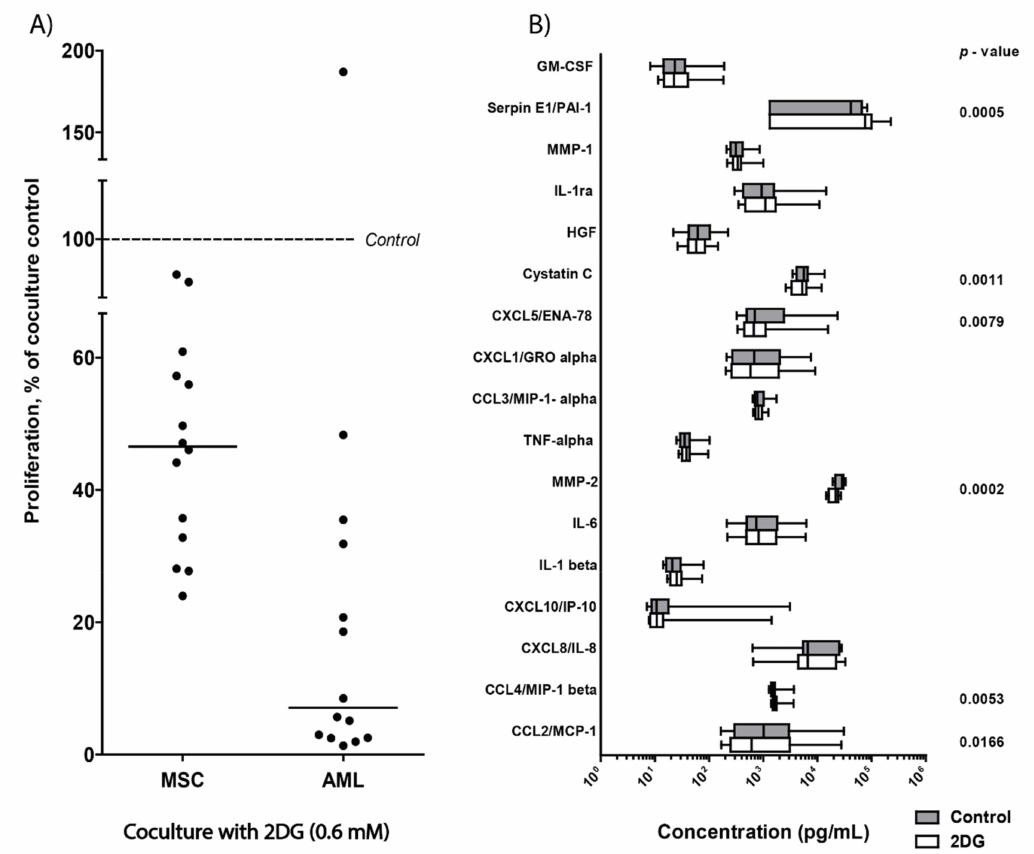
Figure 7. Cell proliferation and mediator release after in vitro coculture of primary human AML cells and normal mesenchymal stem cells (MSCs), after treatment with the glycolytic inhibitor 2DG. Primary AML cells derived from 14 patients were cultured together with normal MSCs in transwell cocultures for 3 days in the presence of 2DG, before proliferation was assayed using the [ 3 H]-thymidine incorporation assay. Mediator levels were also determined in coculture supernatants with and without 48-hour treatment with 2DG, using multiplex analysis. ( A ) E ff ect of 2DG on cell proliferation in MSC-AML cocultures. Proliferation of MSCs or AML cells in 2DG-treated cocultures relative to the inhibitor-free control cocultures (shown as stippled line at 100%) was calculated and an antiproliferative e ff ect by 2DG was then observed both for the MSCs (derived from one donor) and the AML cells (derived from 14 patients) during coculture. The median proliferation of the MSC cells and the AML primary cells after treatment in cocultures is indicated in the figure( - ). ( B ) The constitutive release of soluble mediators in cocultures after 48-hour treatment with 2DG. The results are presented as the median levels with 25 / 75 percentiles (boxes), 5 / 95 percentiles (whiskers). The mediator concentrations (pg / mL) are given on the X-axis as log-values. Significant p -values are shown to the right (Wilcoxon signed rank test; 2DG-treated cocultures compared to untreated cocultures). Grey boxes illustrate mediator levels in untreated cocultures and white boxes indicate levels after treatment with 0.6 mM